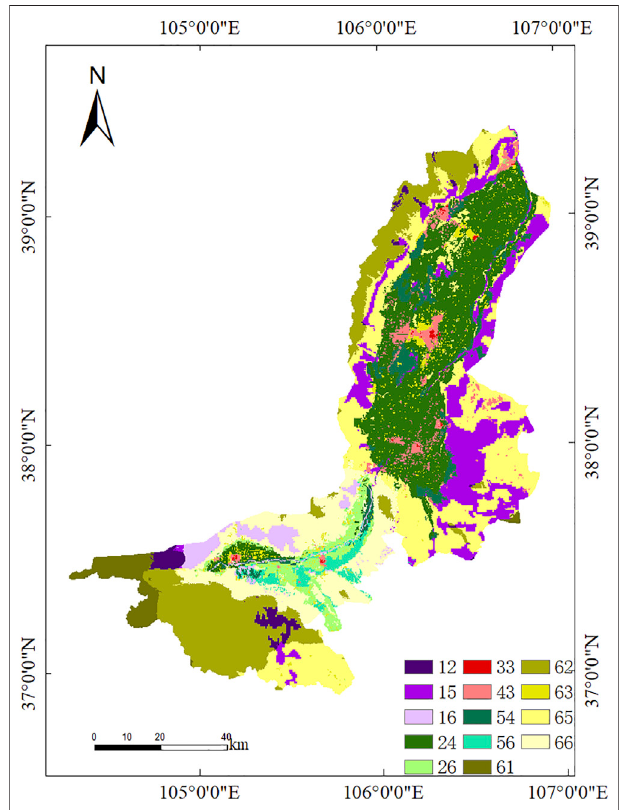
FIGURE 8 | Zoning management in the